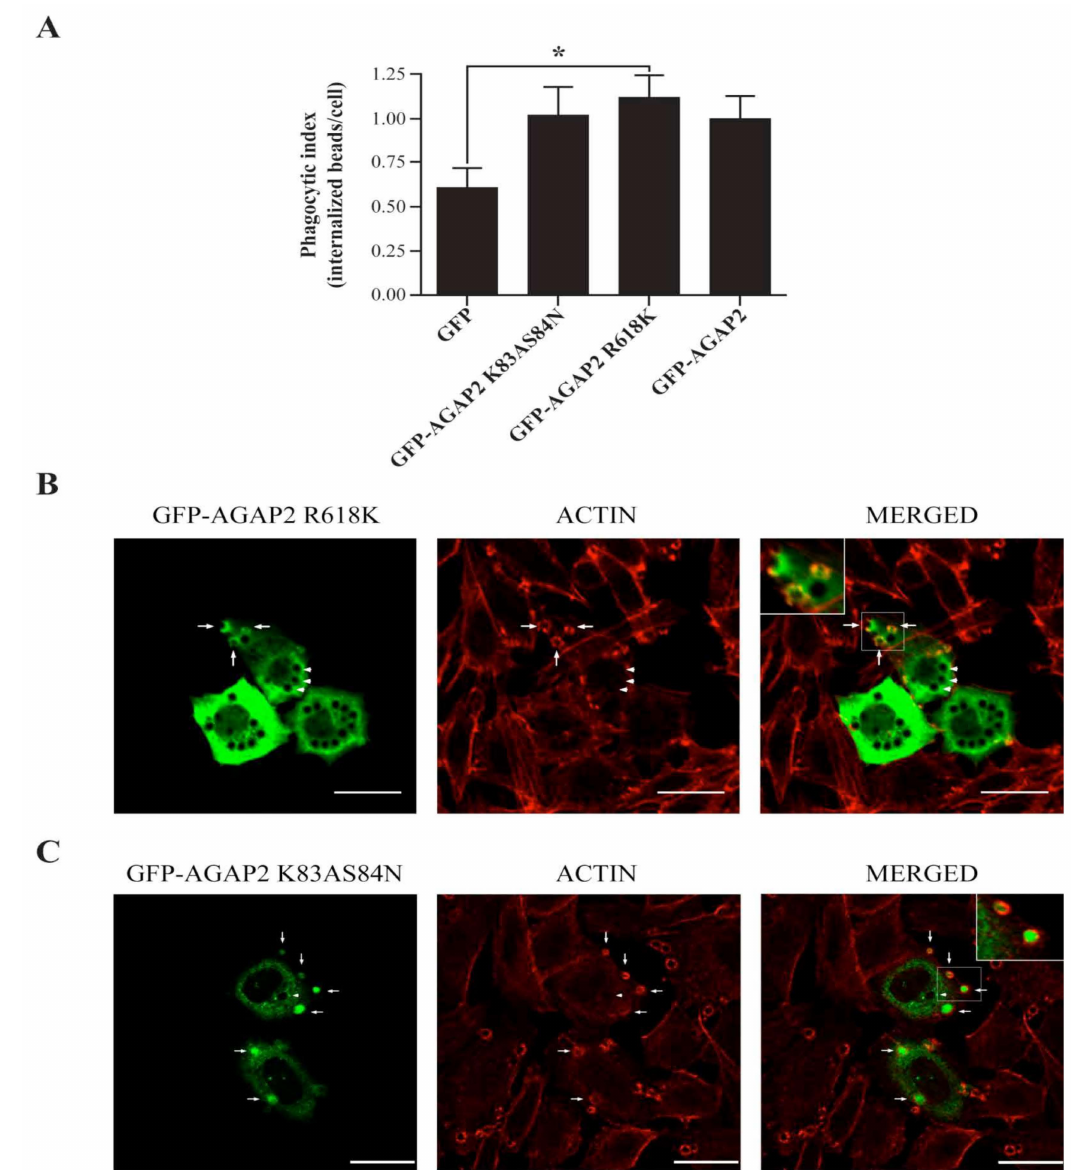
Figure 7. Impact of GAP-and GTPase-deficient AGAP2 on Fc γ -mediated phagocytosis. ( A ) CHO- IIA cells transiently expressing pEGFP-C1, pEGFP-C3-AGAP2K83AS84N, pEGFP-C3AGAP2R618K or pEGFP-C1-AGAP2 were allowed to phagocytose IgG-opsonized beads for 5 min. The number of internalized beads was counted and the phagocytic index calculated as described in Materials and Methods. The mean ± SEM of five independent experiments is plotted with at least 100 cells counted in each case. CHO-IIA cells transiently expressing pEGFP-C3-AGAP2R618K ( B ) or pEGFP- C3-AGAP2K83AS84N ( C ) were allowed to undergo phagocytosis for 30 min or 2 min, respectively. Polymerized actin was labeled with Alexa 594-phalloidin (red). Insets in B and C show a magnifi- cation of the boxed areas. Arrows and arrowheads show phagocytic cups and sealed phagosomes, respectively. Bars, 20 µ m. ( A ) Data are presented as mean ± SEM with p -values from the Student’s unpaired t -test (two-tailed). An asterisk (*) denotes a p -value <